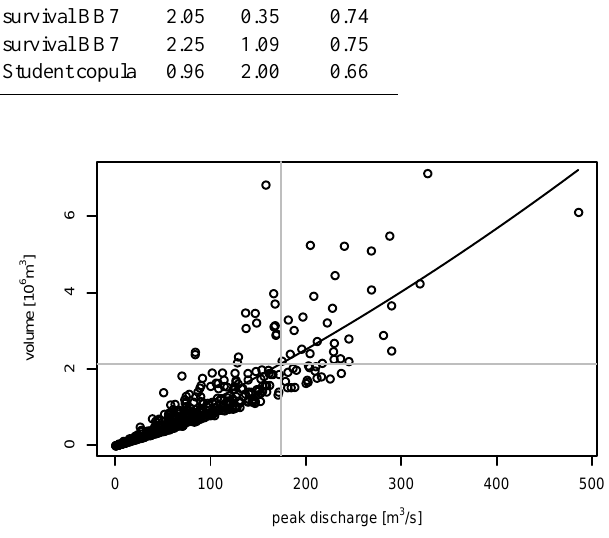
Fig. 5. Illustration of the derivation of the design quantiles based on the regression